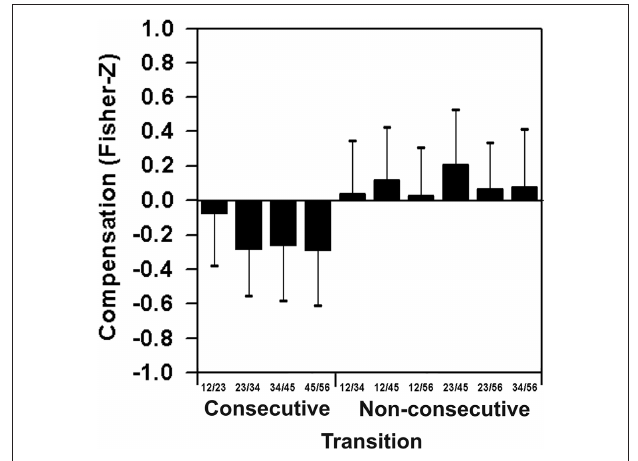
Figure 4 | Lever sequencing: temporal compensation combined across the six nodal points as a function of focus of attention on a nodal point (in-focus), on any other nodal point (out-of-focus), or without any special instruction